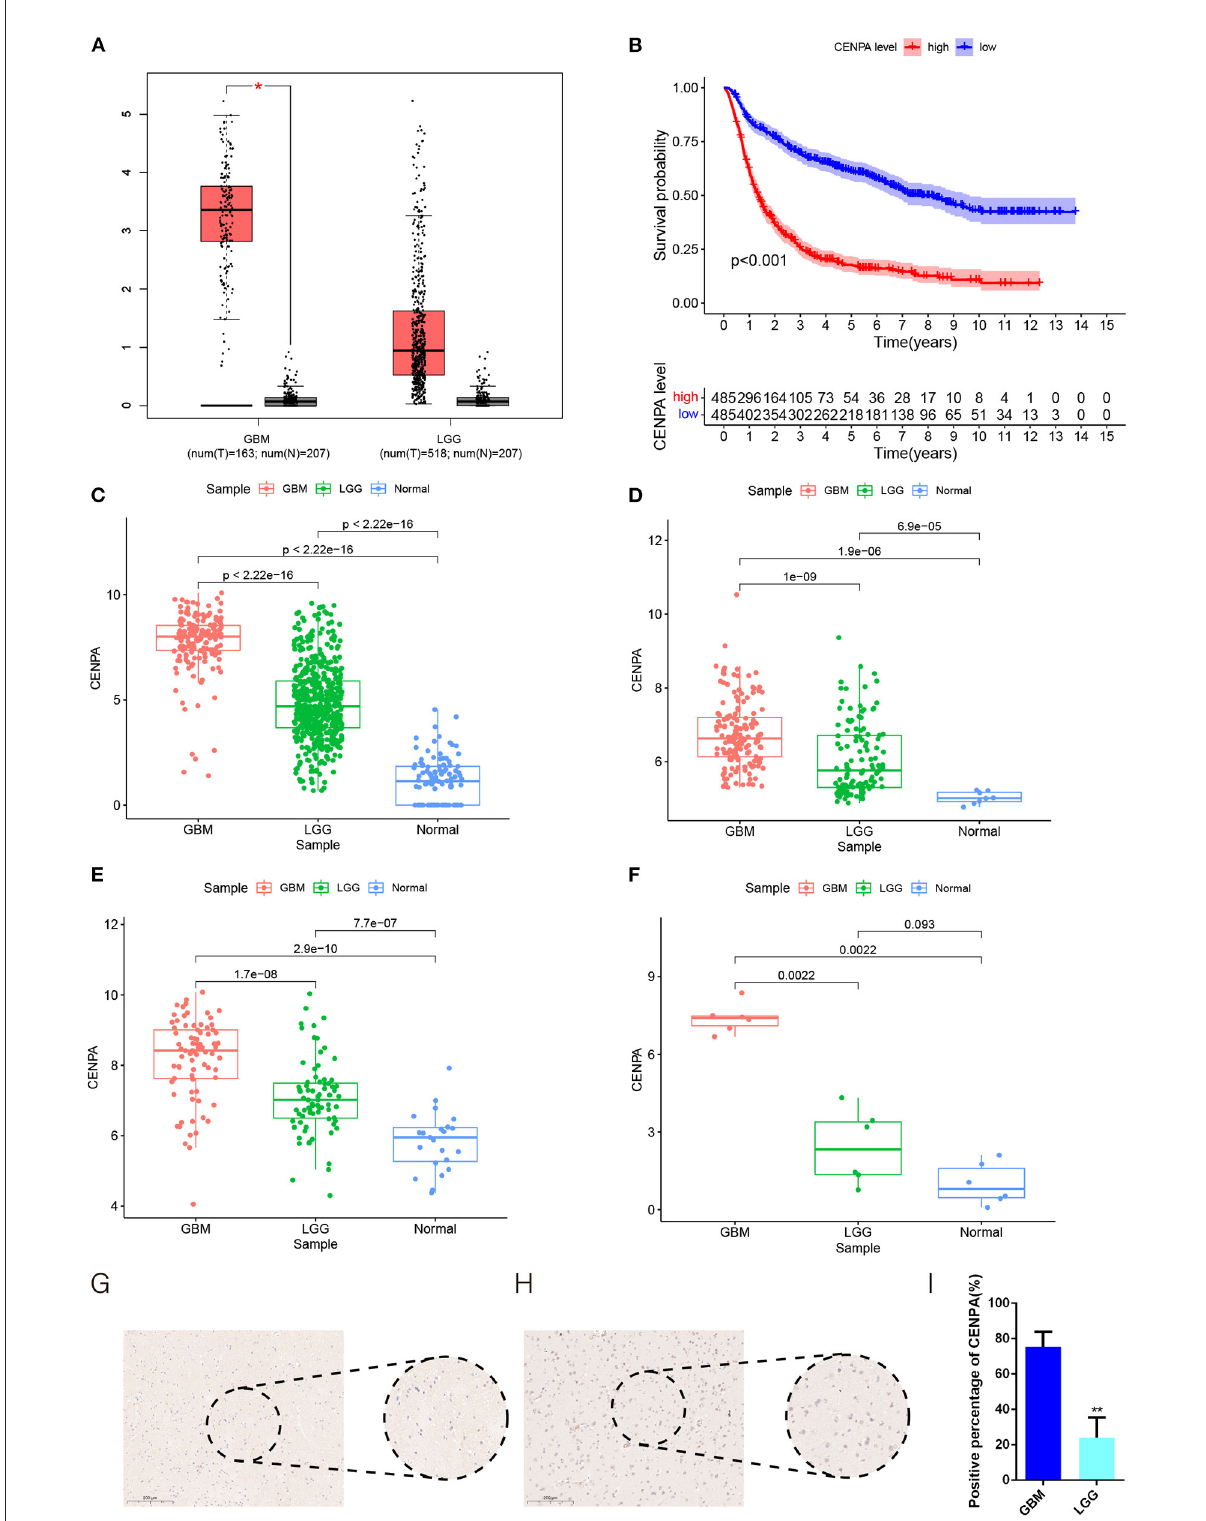
FIGURE2 CENPA expression is upregulated in patients with glioma and suggests a poor prognosis. (A) Expression of CENPA in glioma and normal tissues in the GEPIA database (one-way ANOVA, * P < 0.05). (B) Survival analysis of patients with glioma in the high CENPA and low CENPA groups.